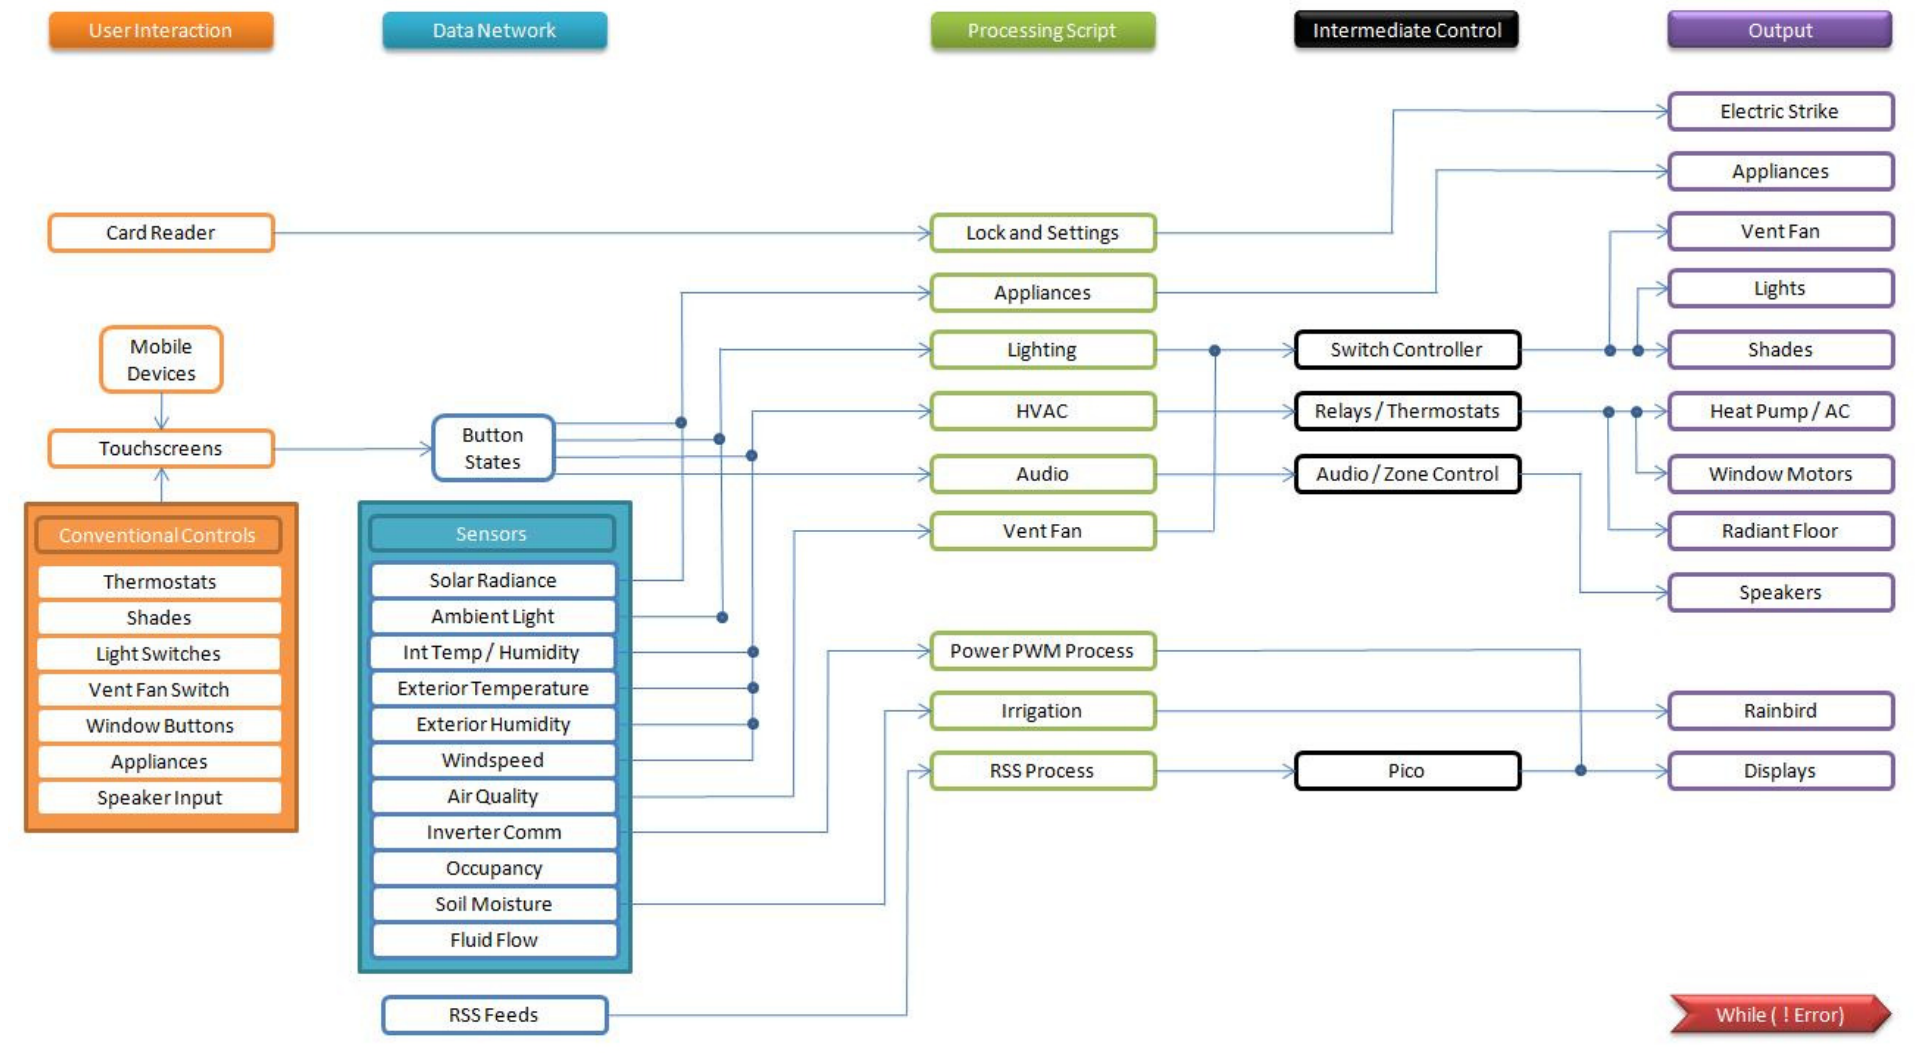
Figure 1. Flowchart of Chameleon’s